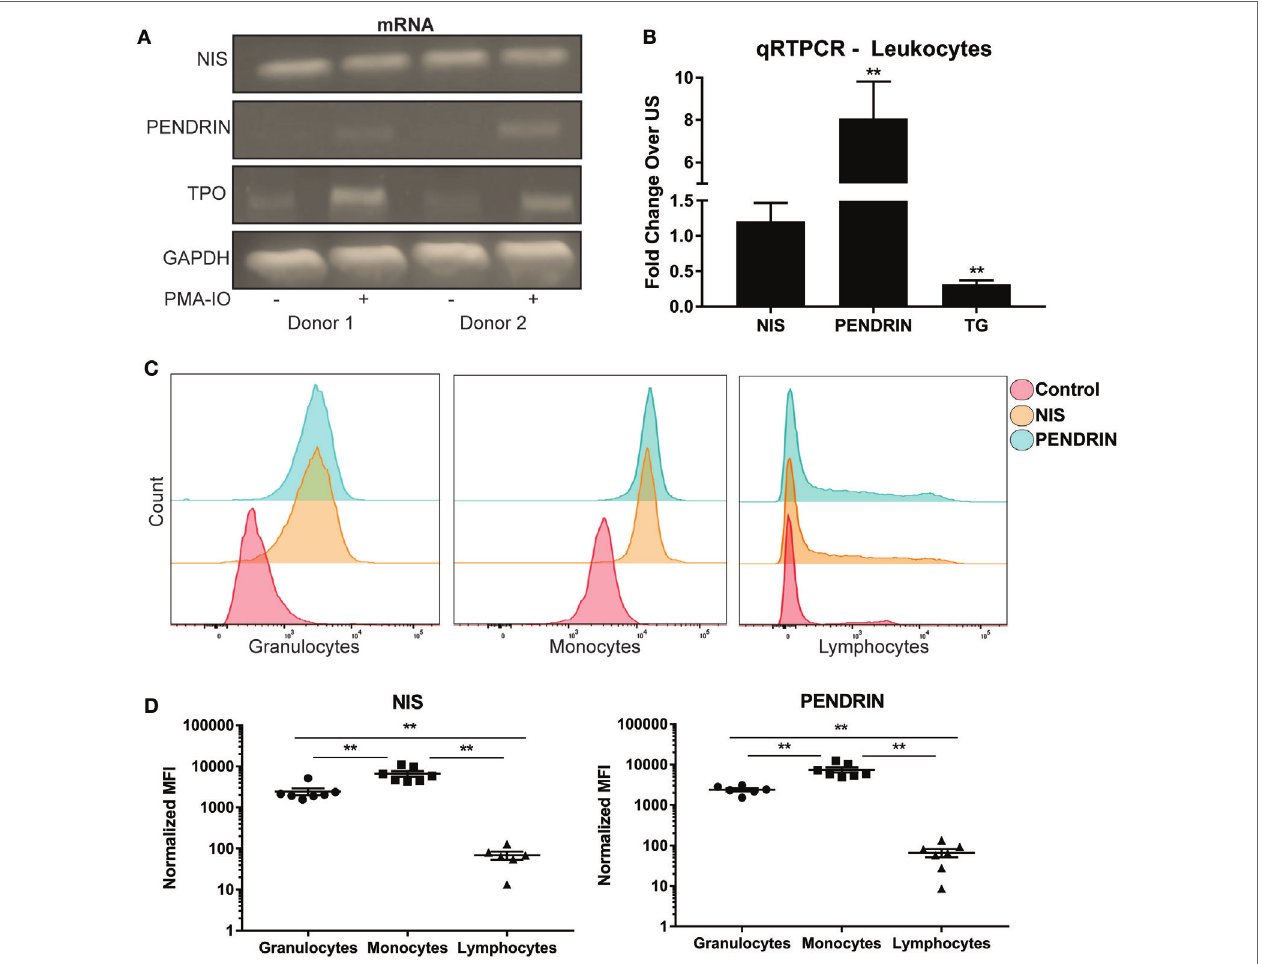
FigUre 1 | Human immune cells express and regulate iodide transporters, thyroglobulin, and thyroid peroxidase. (a) Leukocytes were left unstimulated (US) ( − ) or activated ( + ) with PMA and ionomycin for 18 h, total RNA was extracted, and then the cDNA from samples was amplified with PCR. Shown is DNA gel electrophoresis image of two representative donors. (B) Leukocytes mRNA was amplified using real-time quantitative PCR, and then each gene was normalized to internal B2M control. Fold increase over US controls was graphed ± SEM of nine independent donors. (c) Leukocytes were stained with no antibody (control), NIS, or PENDRIN antibodies. The cells were then stained with secondary Alexa-647 and primary-conjugated CD45 Krome-orange antibodies. Leukocyte subsets (granulocytes, monocytes, and lymphocytes) were gated on based on CD45 and side-scatter characteristics. The gated subset histograms are shown as cell counts and antibody staining intensity representative of six donors. (D) Median fluorescent intensity (MFI) values from panel (c) were subtracted from background staining and then graphed ± SEM of six to seven independent